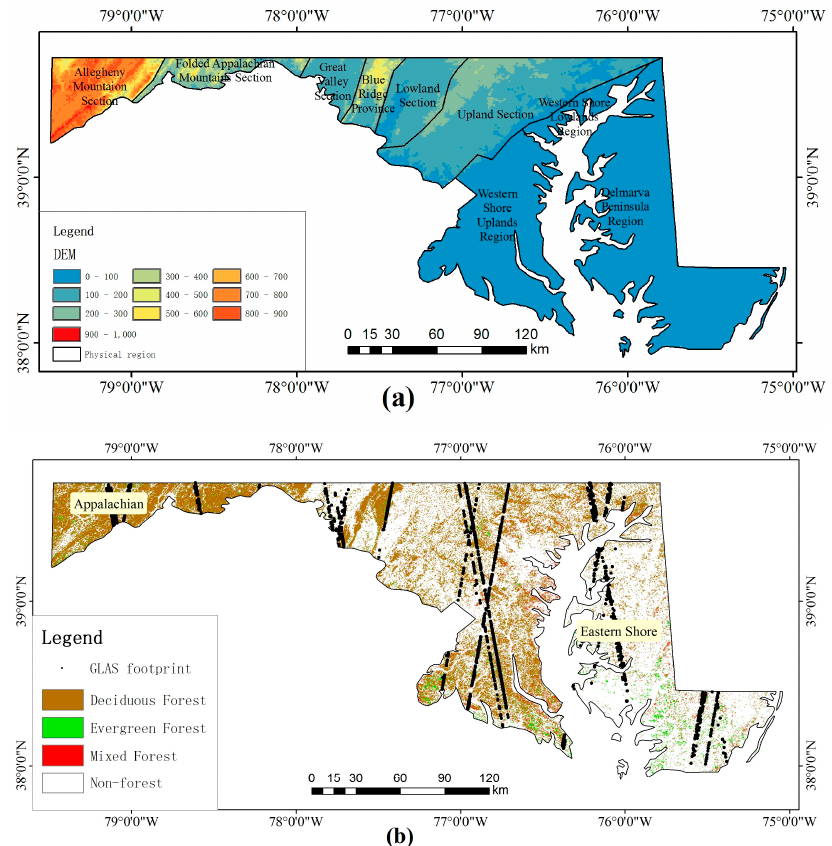
Figure 1. Overall introduction to the study area. ( a ) The elevation map and the distribution of the physical regions. ( b ) The distribution of the forest in Maryland and Geoscience Laser Altimeter System (GLAS) footprints located in forest areas.